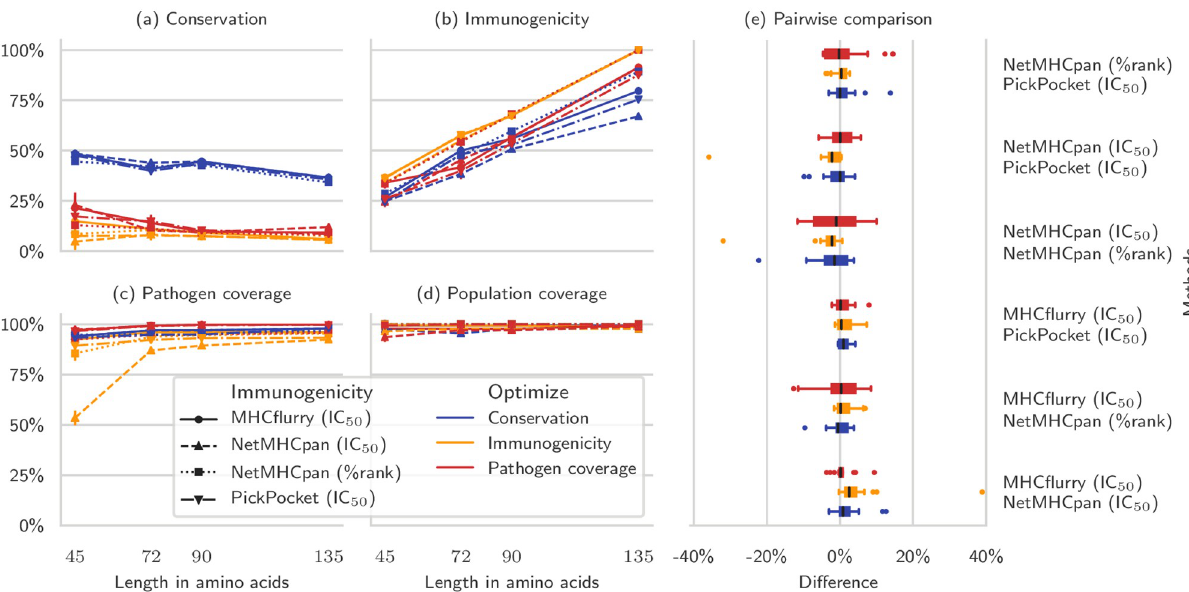
Fig 10. Effect of different immunogenicity predictors on vaccines optimized for different objectives. We repeated the experiment shown in Fig 8 using different epitope immunogenicity predictors. For each bootstrap, we designed mosaic vaccines optimizing their conservation (blue), immunogenicity (yellow), or pathogen coverage (red) and compared the vaccines in terms of conservation (a), immunogenicity (b), pathogen coverage (c), and population coverage (d). (e) shows the pairwise difference of the four metrics across all vaccine sizes, separated by optimization objective, between all pairs of immunogenicity functions. There is little variation among the results obtained with different immunogenicities.